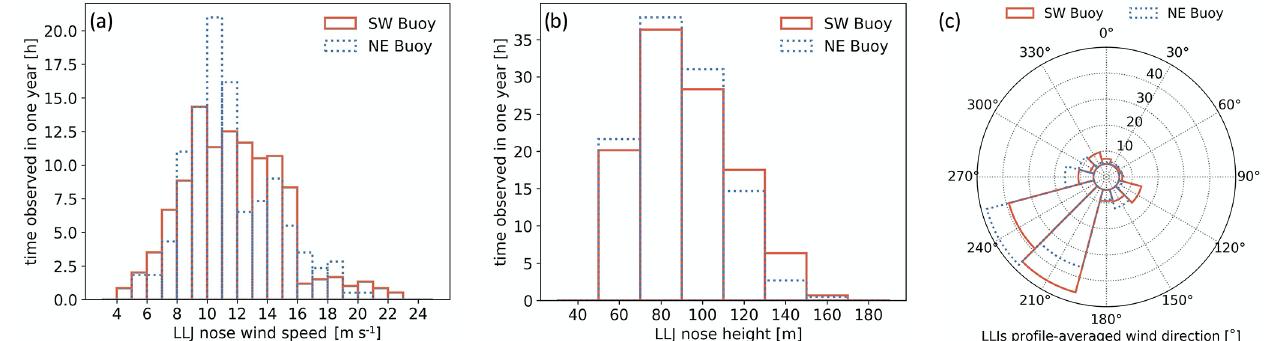
Figure 10. Number of hours of LLJ as a function of nose wind speed (a) , nose height (b) and vertically averaged wind direction (c) . Distributions consider all 10min profiles featuring an LLJ.